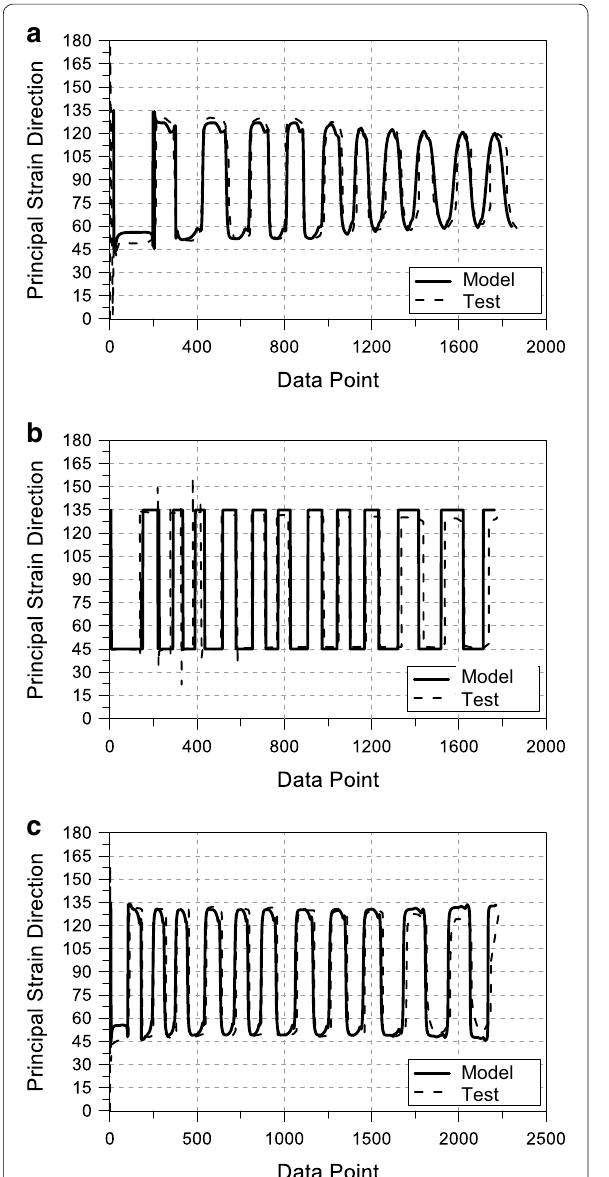
Fig. 6 Measured vs. predicted principal strain directions: a Specimen SE8, b Specimen SE9, c Specimen SE10.